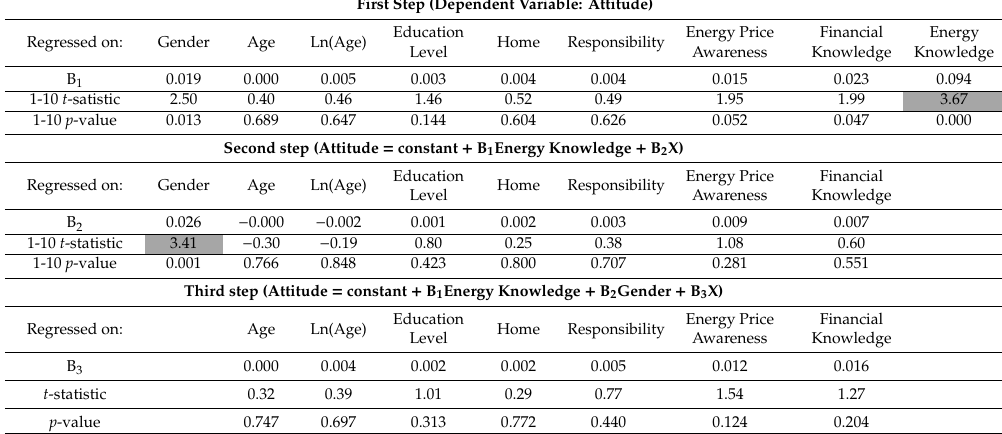
Table A2. Stepwise estimations considering attitude as the dependent variable.